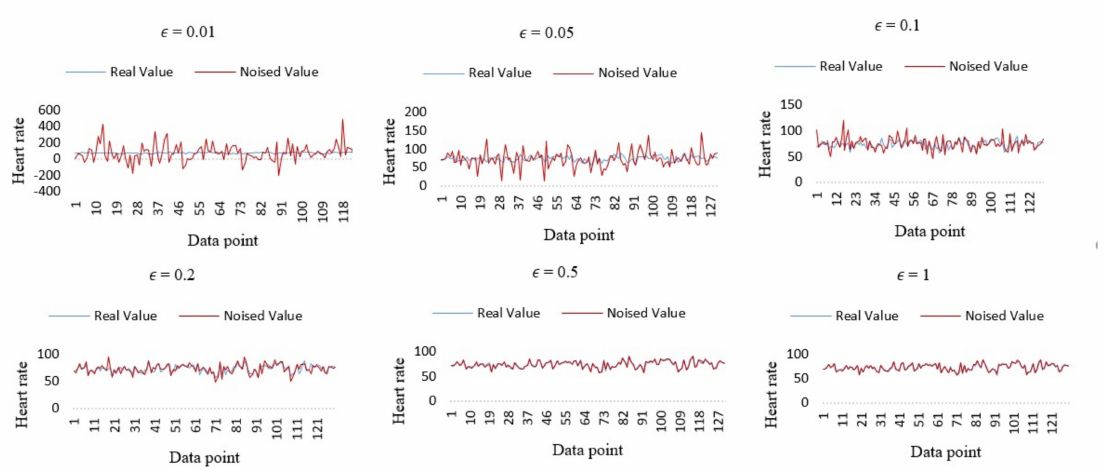
Figure 6. Evaluation of differential privacy with six different values of ε .